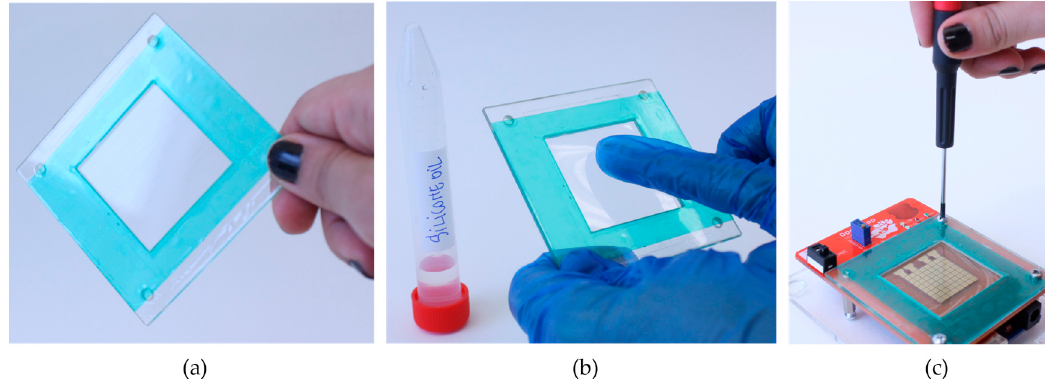
Figure 10. The simplest coating technique uses ETFE film and silicone oil. ( a ) The first step is to glue the ETFE film on the cartridge using double sided tape; ( b ) Next, the user applies a thin layer of silicone oil; ( c ) Finally, the cartridge is mounted on top of O PEN D ROP .